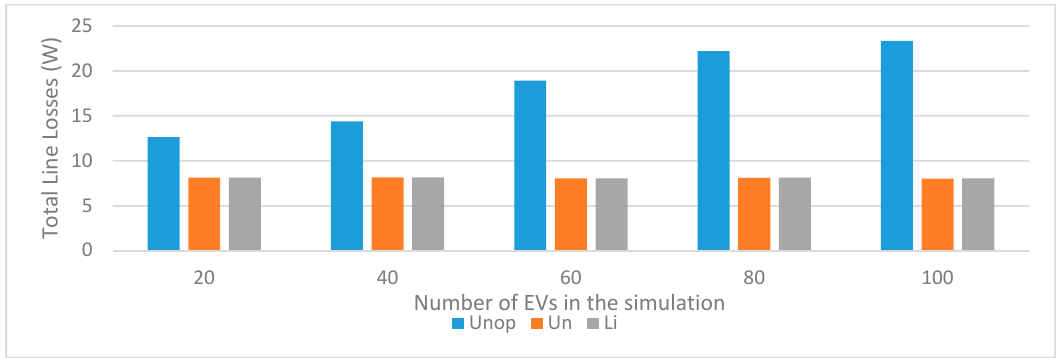
Figure 16. Worst case total line losses (W) Unop—Unoptimized; Un—Unlimited configuration optimization; Li—Optimization with no node connected to more than 25% of the vehicles charging at that hour.